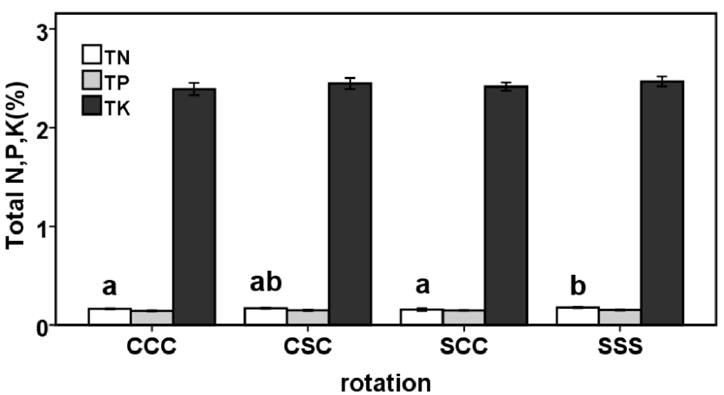
Figure 5. The effect of crop rotations on percentage of total soil N (TN), P (TP), and K (TK). Error bars represent standard deviations ( n = 3). Different letters show significant differences among the treatments ( p < 0.05).